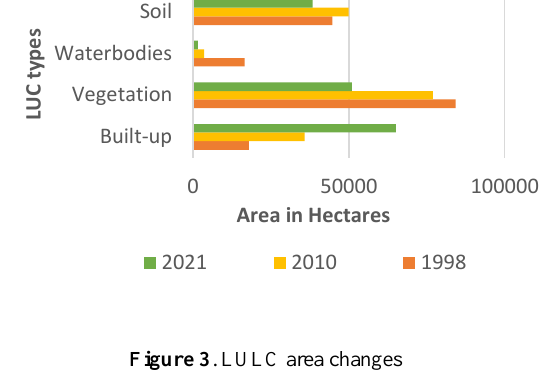
Figure 3 . LULC area changes